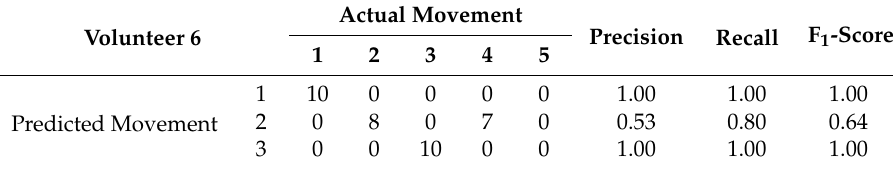
Table A6. Results Volunteer 6.